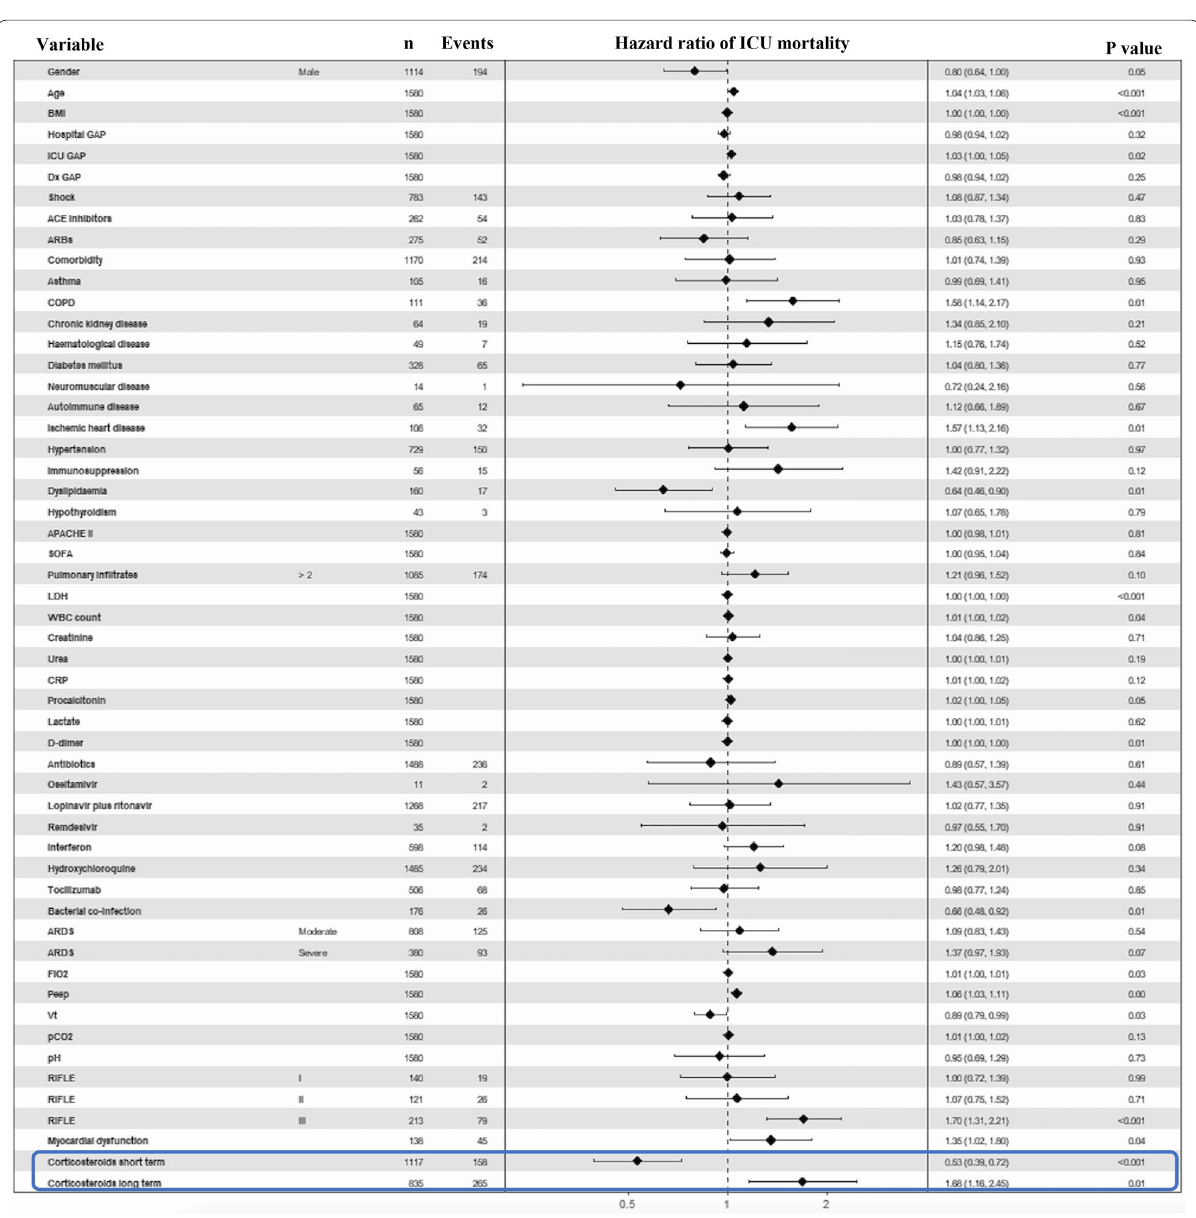
Fig. 2 Forest plot of the cause‑specific hazard model (time‑dependent Cox regression) for ICU mortality. The time‑dependent Cox regression included all the variables and those were adjusted as potential confounding factors. The interaction with time in this case was modelled using the step function to deal with non‑proportional hazards of the covariate of interest (corticosteroid treatment). Through the step function, a partitioning of the time axis was made at day 17th, when the effect of the covariate changed over time. Consequently, the model allowed to estimate the effect of the treatment covariate before (corticosteroid treatment short‑term) and after (corticosteroid treatment long‑term) the 17th day of ICU admission. Notably, the regression model showed the protective effects of corticosteroids on survival up to day 17 of admission to the ICU, although these effects changed over time, as after the 17th day corticosteroid treatment at ICU admission was associated with higher mortality. Diagnosis GAP means the time (days) from disease onset to the confirmation of the diagnosis of SARS‑CoV‑2 infection; Hospital GAP (days) means the time from disease onset to hospital admission. ICU GAP (days) means the time from hospital to ICU admission. BMI body mass index, ACE angiotensin‑converting enzyme, ARBs angiotensin receptor blockers, COPD chronic obstructive pulmonary disease, APACHE Acute Physiology And Chronic Health Evaluation, SOFA Sequential Organ Failure Assessment, LDH lactate dehydrogenase, WBC white blood cells count, CRP C‑reactive protein, ARDS acute respiratory distress syndrome, FiO 2 fraction of inspired oxygen, Peep positive end‑expiratory pressure, Vt tidal volume, pCO 2 partial pressure of carbon dioxide, RIFLE criteria Risk, Injury, Failure, Loss, End